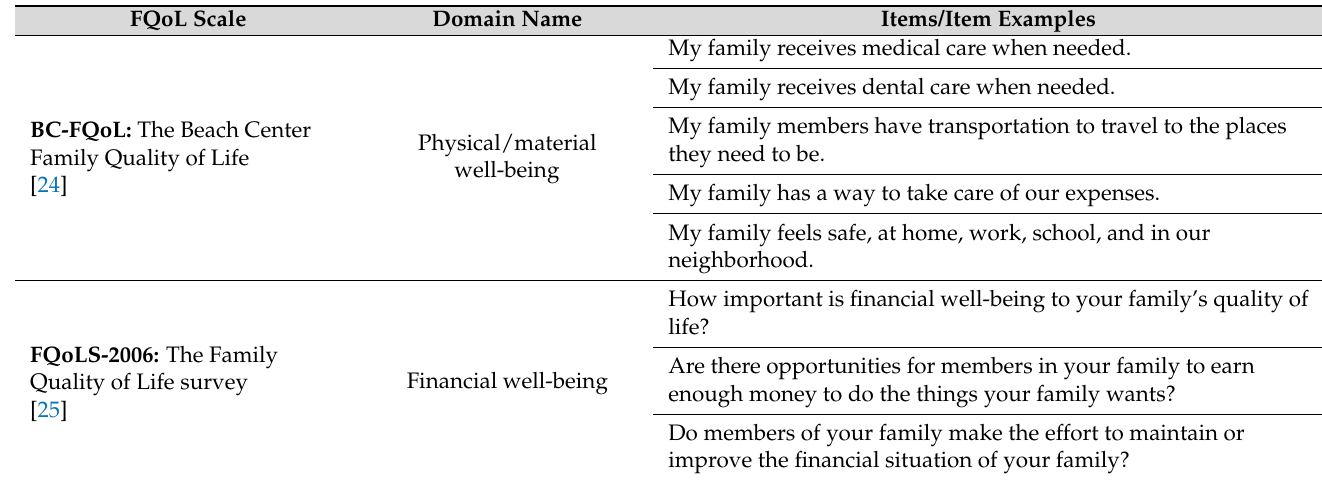
Table 13. Items/item examples considered in the domain of financial/material well-being within each FQoL